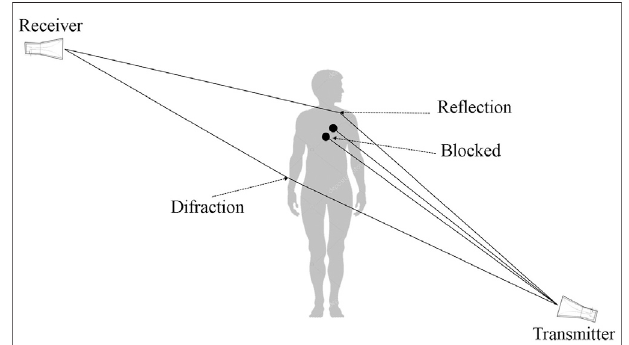
FIGURE 4 | Human interaction propagation mechanisms between a transmitter and receiver.